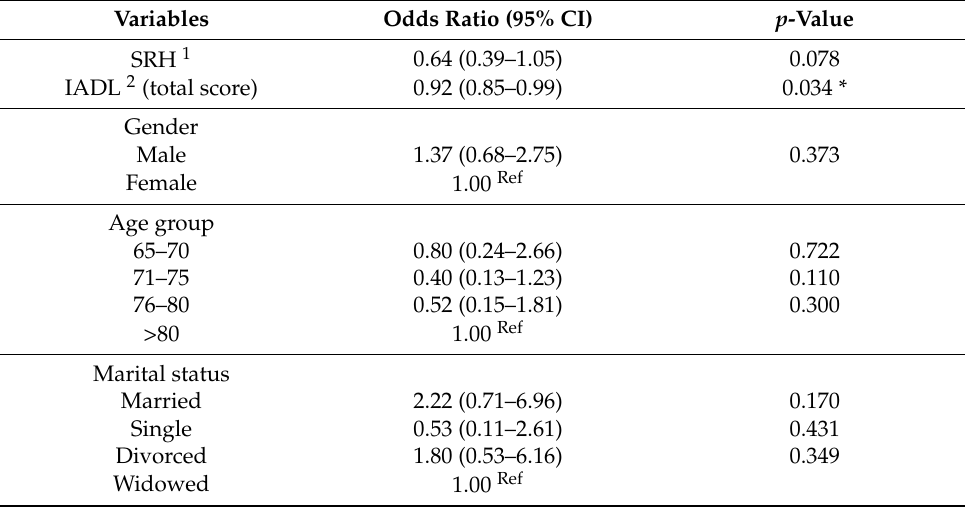
Table 8. Ordinal Regression Analysis on the predictors of